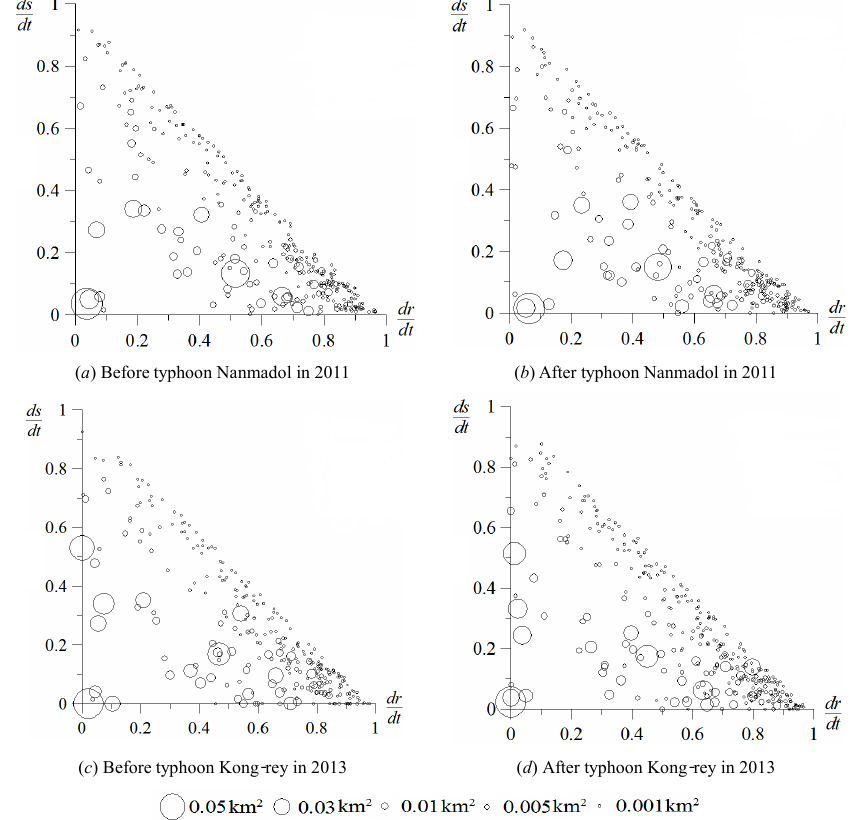
Figure 8: Spatial Distribution of Bare Land in the Study Area before and after the Typhoons Nanmadol (Top) and Typhoon Kong- rey (Bottom), the scales of bubble reflect the area of each bare land. Figure 8. Spatial distribution of bare land in the study area before and after the typhoons Nanmadol (top) and Kong-rey (bottom). The sizes of the bubbles reflect the areas of bare